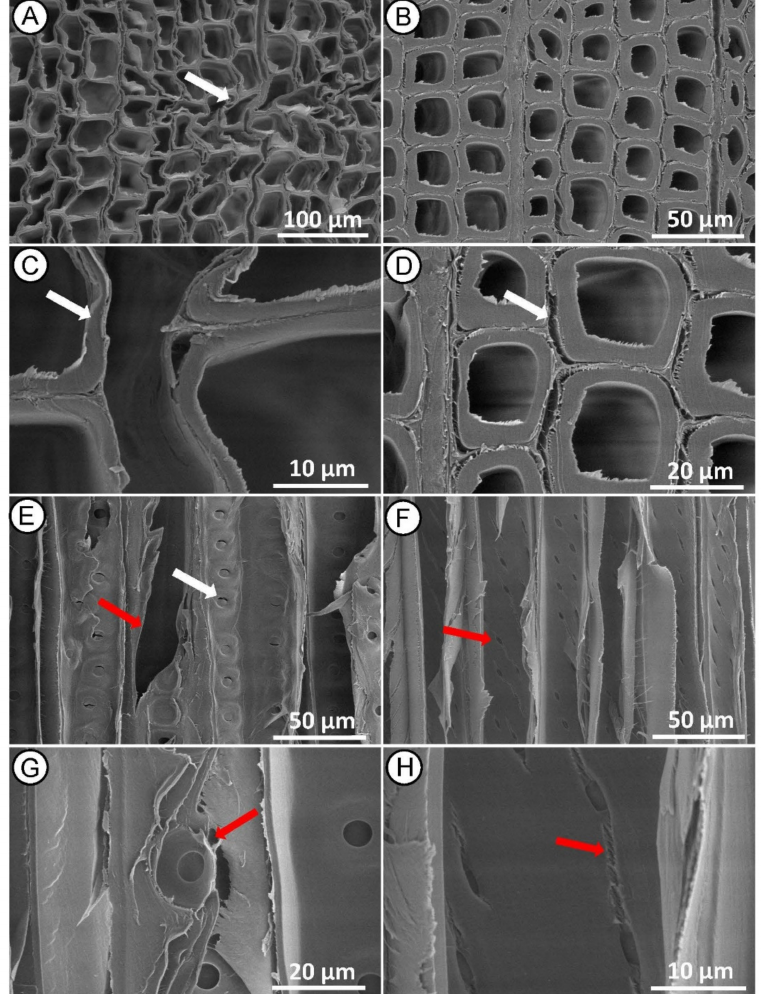
Figure 6. SEM micrographs of Norway spruce heartwood after HI MW treatment. Cross section showing tissue distortion (( A )—white arrow) and collapsed tracheids in earlywood (( C )—white arrow) and detachment of middle lamellas between latewood tracheids (( B , D )—white arrow). Radial section showing longitudinal tracheid fractured (( E )—red arrow), rupture to bordered pits (( E )— white arrow) and damage of pit membrane between tracheid walls (( G )—red arrow) and propagation of cracks from the poles of cross-field pits (( F , H )—red